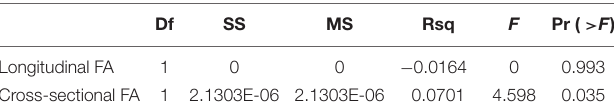
TABLE 3 | ANOVA test results for statistically significant differences in longitudinal and cross-sectional humeral fluctuating asymmetry (FA) across developmental